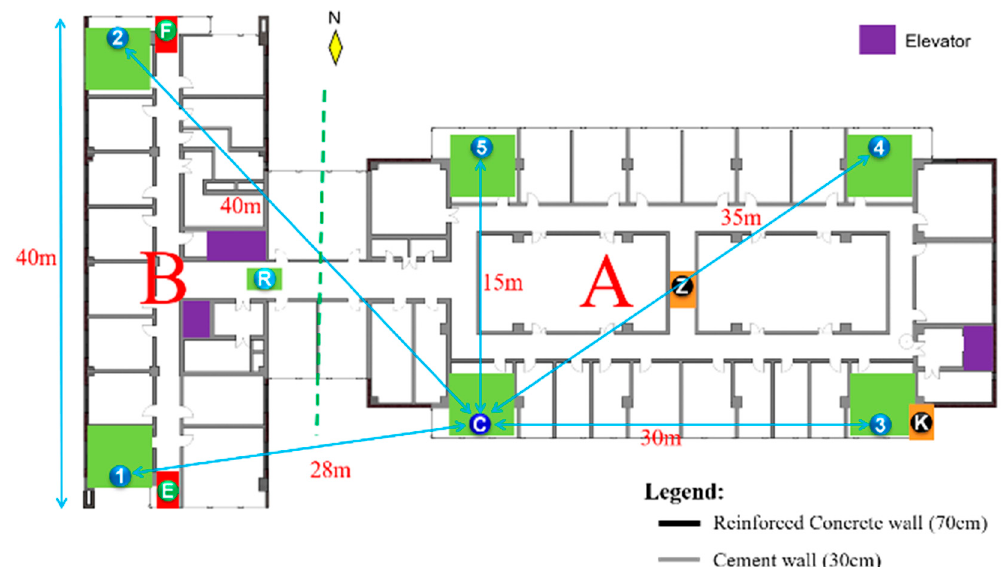
Figure 2. Floor-level detail of the measured building.